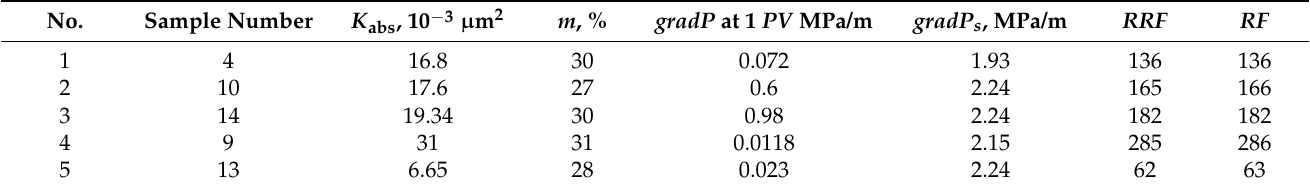
Table 8. Results of the core flooding tests at a single core model of the proposed polymer composition with a gel-time modifier.